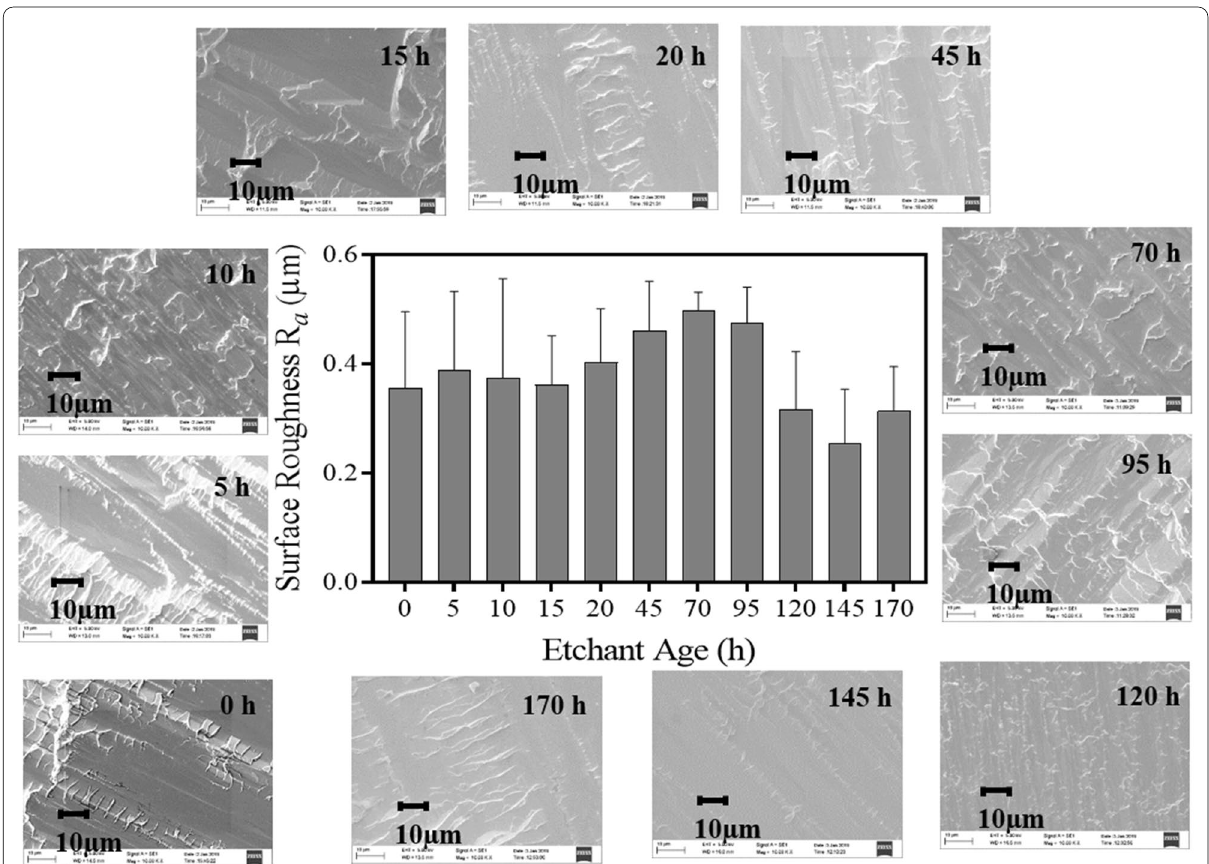
Fig. 46 Etched surface roughness (Ra) and corresponding surface morphologies of Si{110} etched in 10% NH 2 OH etchant age at 70 1 °C ±